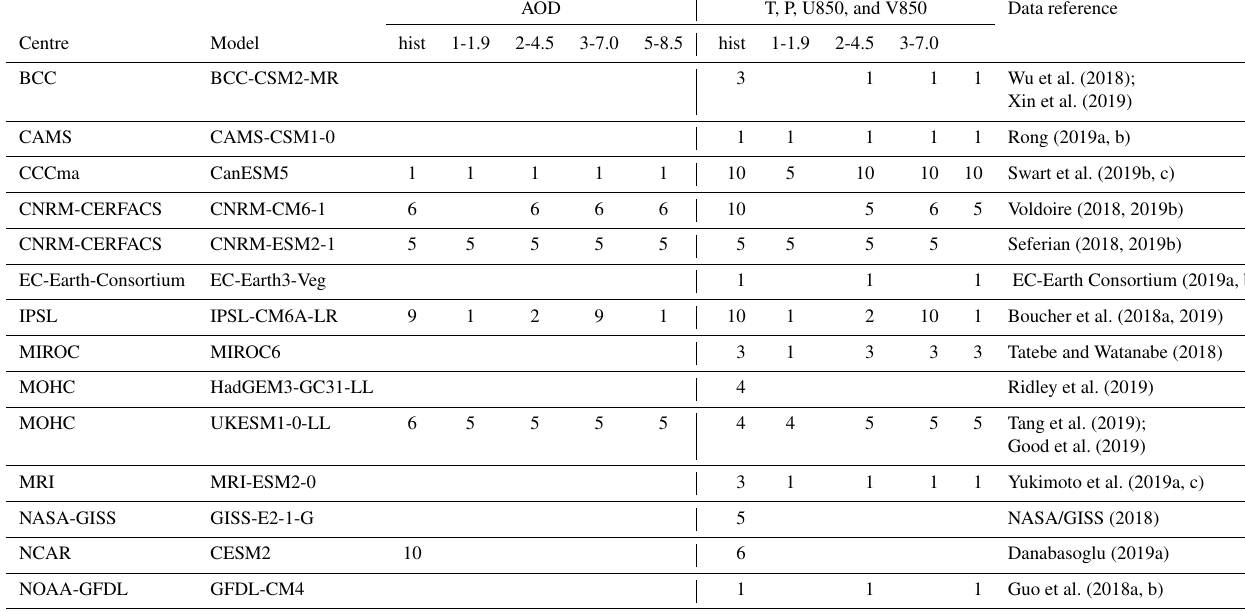
Table 1. CMIP6 models and the number of ensemble members for each used in this